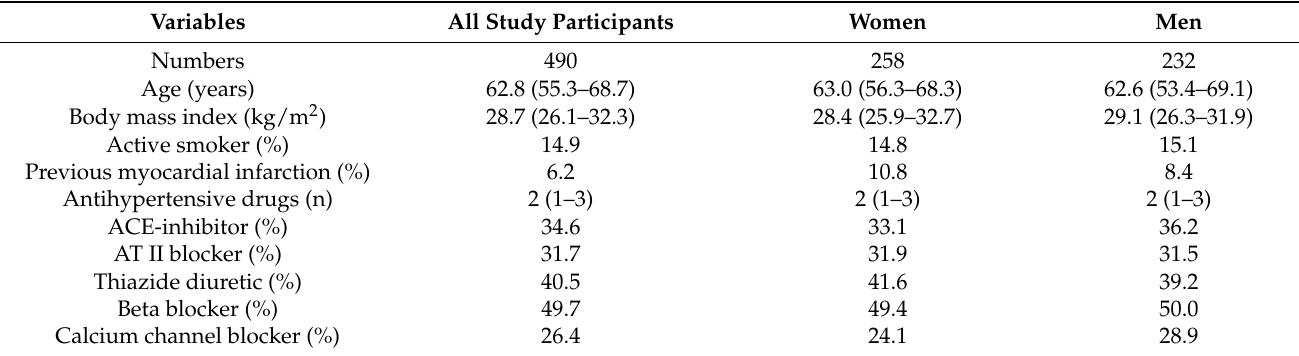
Table 1. Selected baseline characteristics of all study participants.